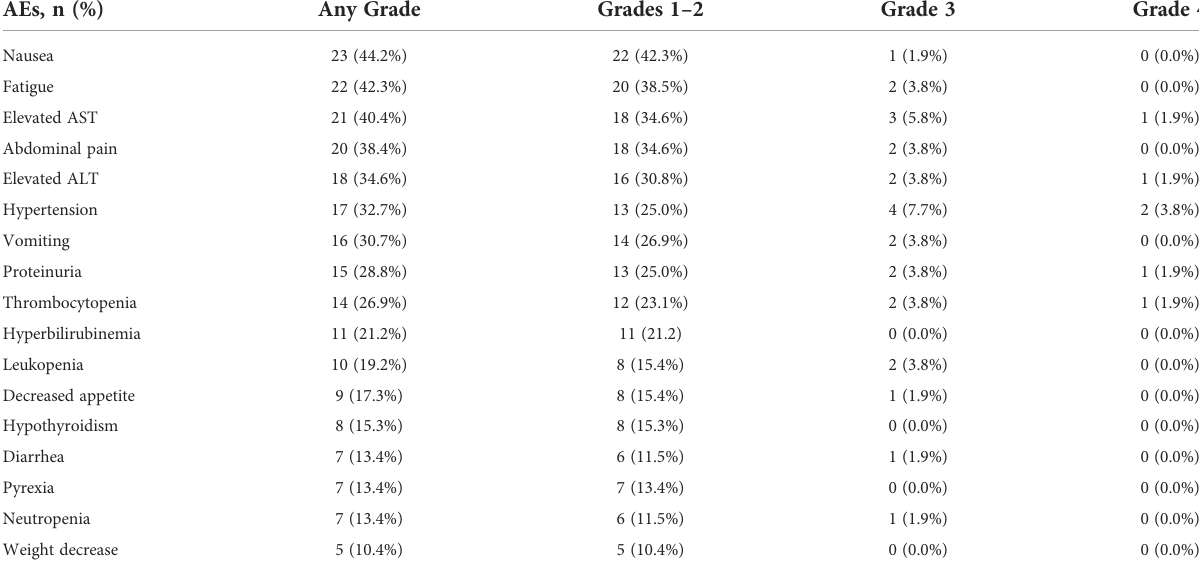
TABLE 3 Treatment-related adverse events occurring at ≥ 10% incidence for all grades. AEs, n (%)